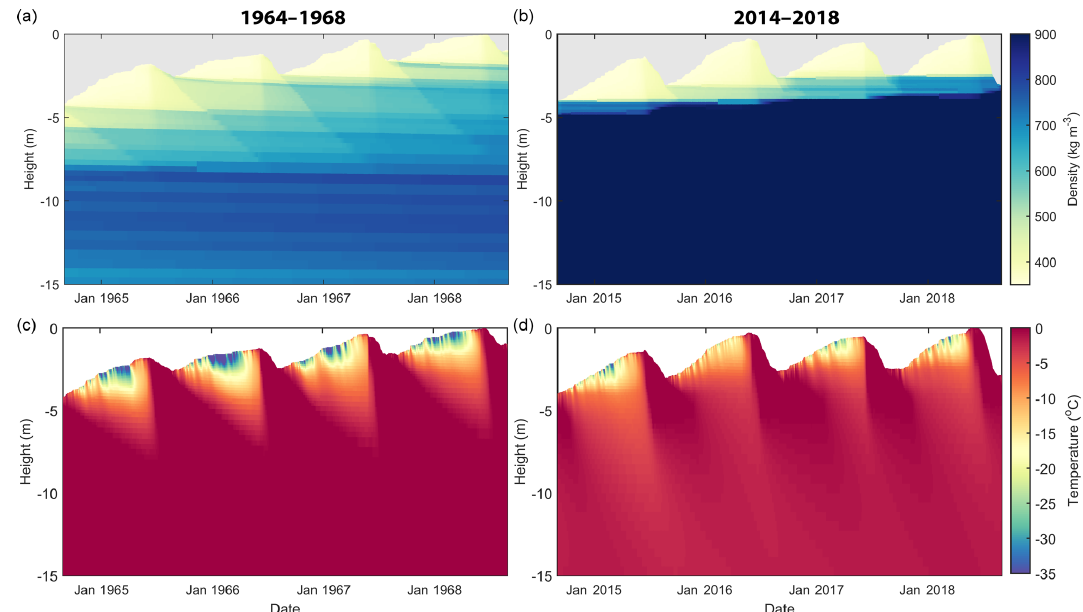
Figure 8. Subsurface density (a, b) and temperature (c, d) evolution during the periods 1964–1968 (a, c) and 2014–2018 (b, d) . The corresponding geographic location of the site is indicated in Fig.